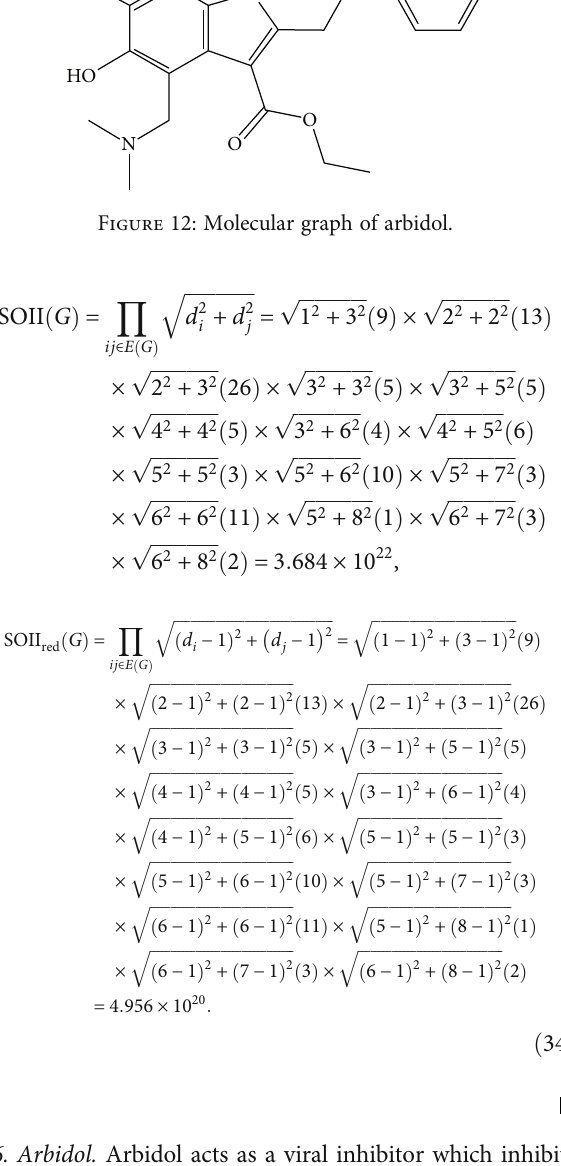
ffiffiffiffiffiffiffiffiffiffiffiffiffiffiffiffiffi 1 + 3 − 2 ffiffiffiffiffiffiffiffiffiffiffiffiffiffiffiffiffi 3 + 3 − 2 ffiffiffiffiffiffiffiffiffiffiffiffiffiffiffiffiffi 4 + 4 − 2 ffiffiffiffiffiffiffiffiffiffiffiffiffiffiffiffiffi 3 + 7 − 2 ffiffiffiffiffiffiffiffiffiffiffiffiffiffiffiffiffi 5 + 6 − 2 ffiffiffiffiffiffiffiffiffiffiffiffiffiffiffiffiffi 6 + 7 − 2